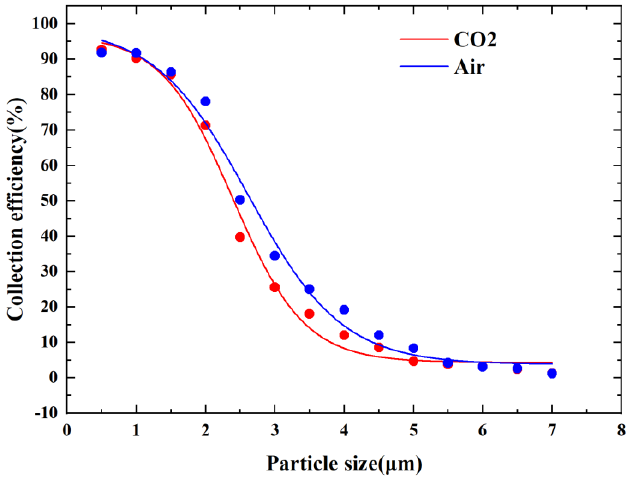
Figure 15. CE curves with different fluids.